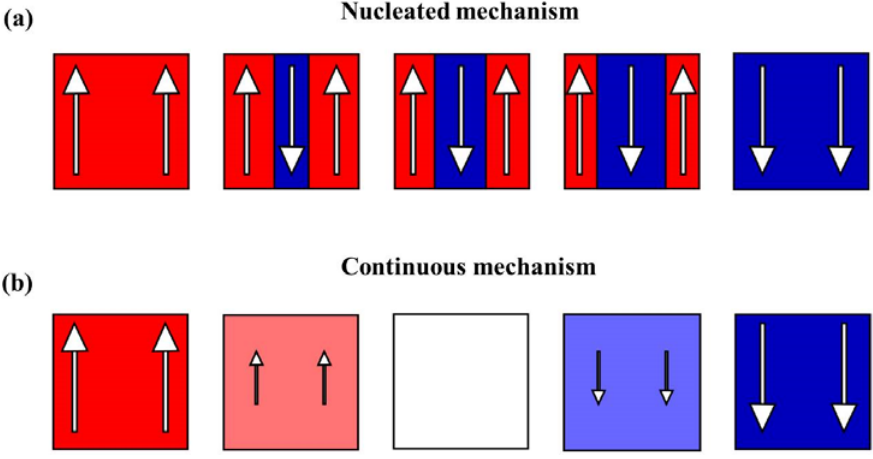
Figure 11. Schematic of polarization evolution during switching in a uniaxial ferroelectric: ( a ) discontinuous nucleation and growth of inverted domains (explained by Kolmogorov-Avrami-Ishibashi (KAI) mechanism); ( b ) continuous, uniform decrease of the polarization magnitude through zero without domain formation (explained by Landau-Ginzburg-Devonshire (LGD) mechanism). Arrows indicate the orientation and magnitude of polarization